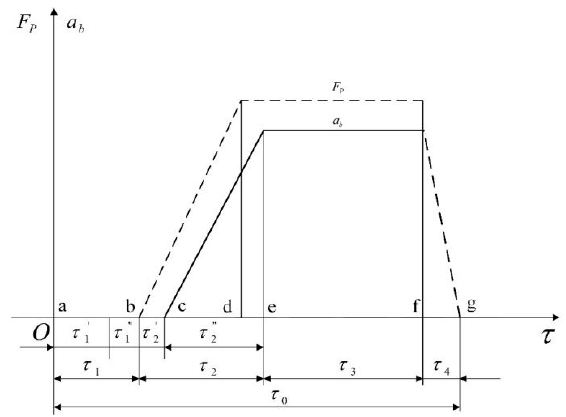
Figure 6. Vehicle braking process.